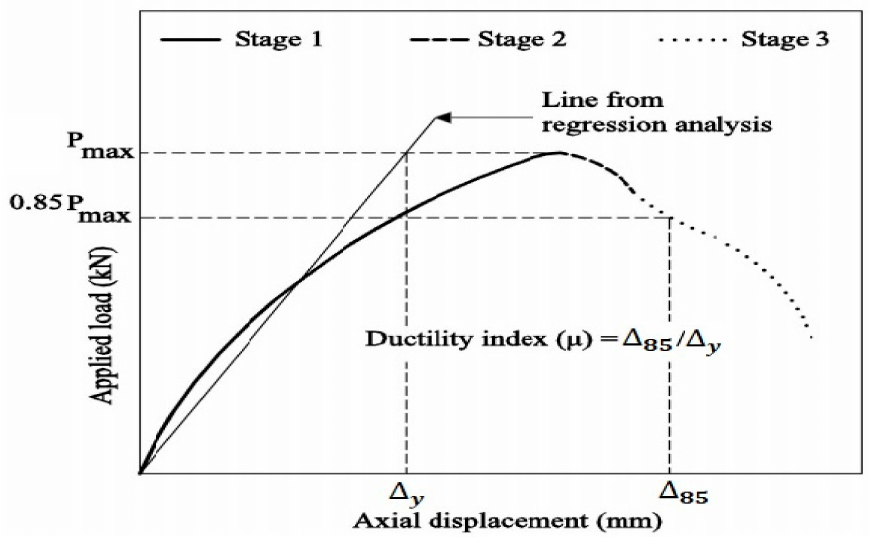
Figure 4. The general load–displacement response of the column